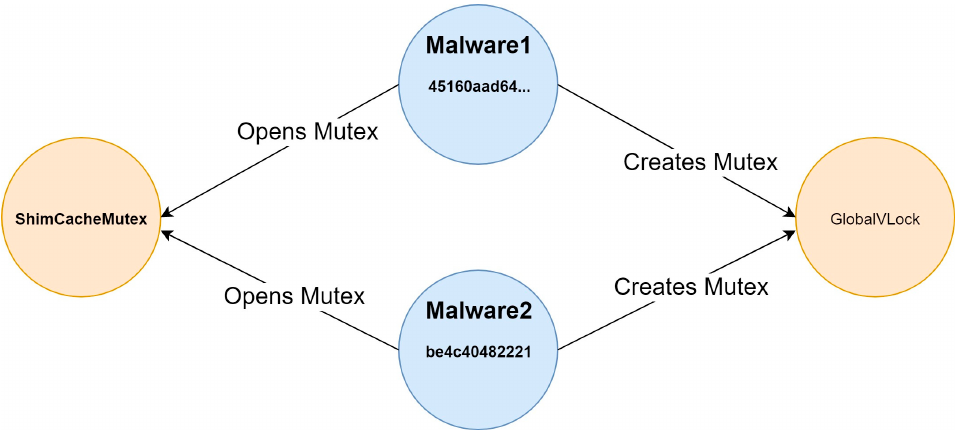
Figure 9. Despite initial false positives, additional analysis often produces correct results.